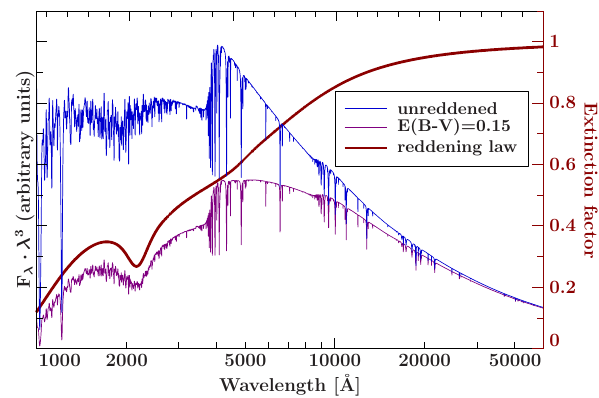
Figure 3. The impact of interstellar reddening on SEDs of a B star for moderate interstellar reddening by E(B-V)=0.15 mag. The reddening law is from Fitzpatrick